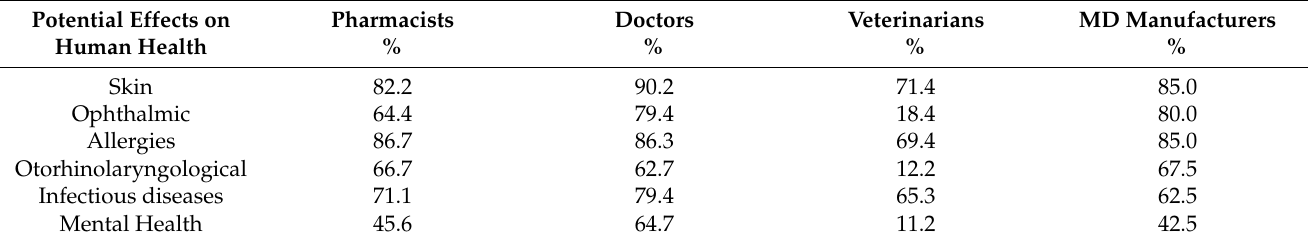
Table 1. Percentage of reply given to question about potential effects on human health caused by